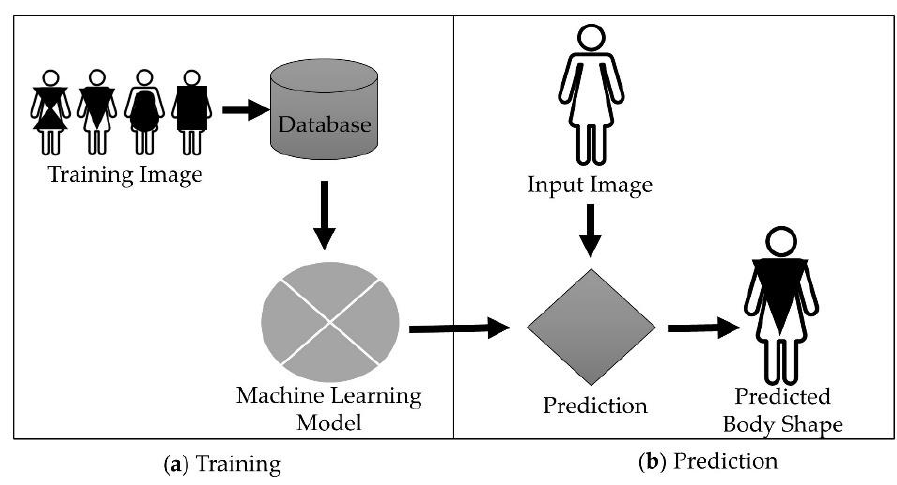
Figure 2. Our proposed body shape detection method which uses image processing and machine learning algorithms with our database. The proposed detection method first trains itself with training images (see ( a ) Training), and then the trained machine predicts the body shapes of unknown input images (see ( b ) Prediction).